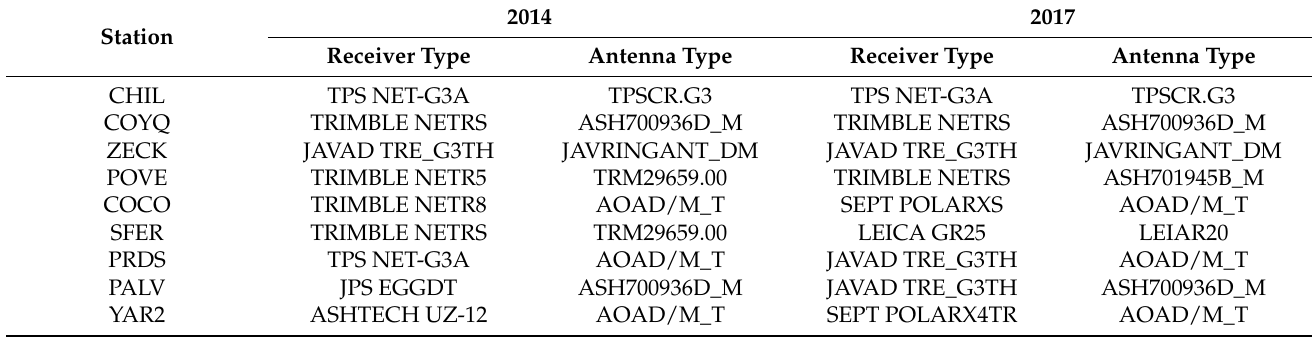
Table 2. Information on receiver and antenna types used by the analyzed